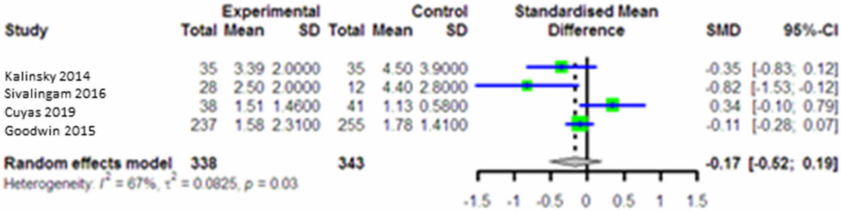
Figure 4. Forest plot of the meta-analysis to compare homeostatic models of insulin resistance (HOMA-IR) between intervention and control